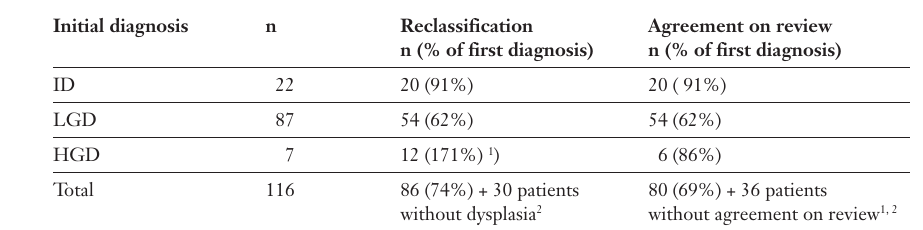
Reclassification of dysplasia.